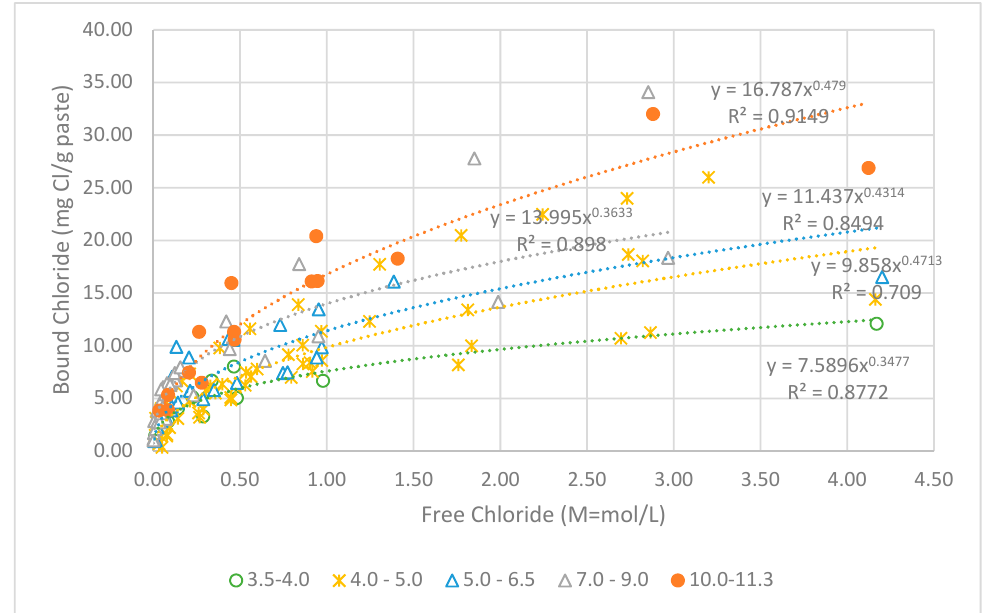
Figure 16. Bound Chloride versus free chloride for different Al 2 O 3 content.